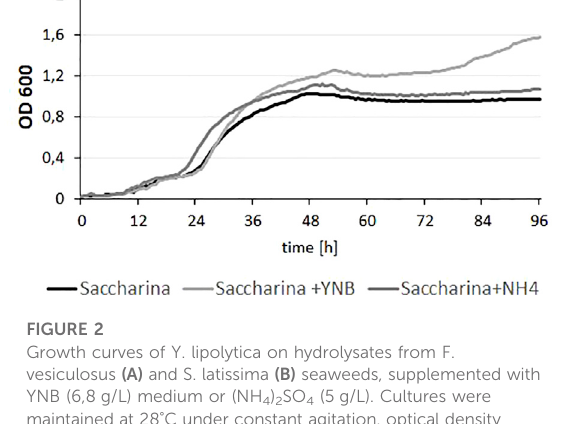
FIGURE 2 Growth curves of Y. lipolytica on hydrolysates from F. vesiculosus (A) and S. latissima (B) seaweeds, supplemented with YNB (6,8 g/L) medium or (NH 4 ) 2 SO 4 (5 g/L). Cultures were maintained at 28 ° C under constant agitation, optical density of each culture was measured every 30 min and each condition was performed with fi ve